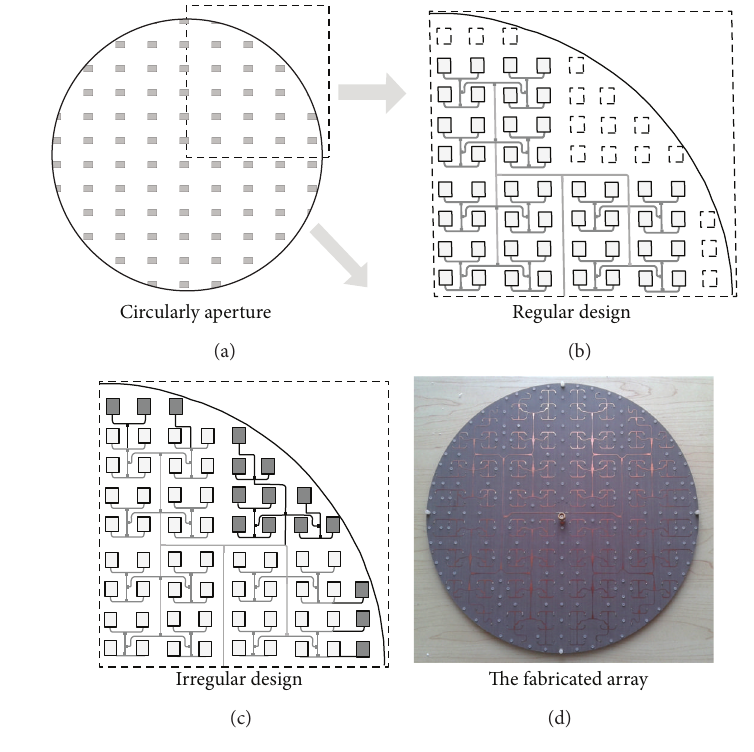
Figure 6: The layout of the circular array.